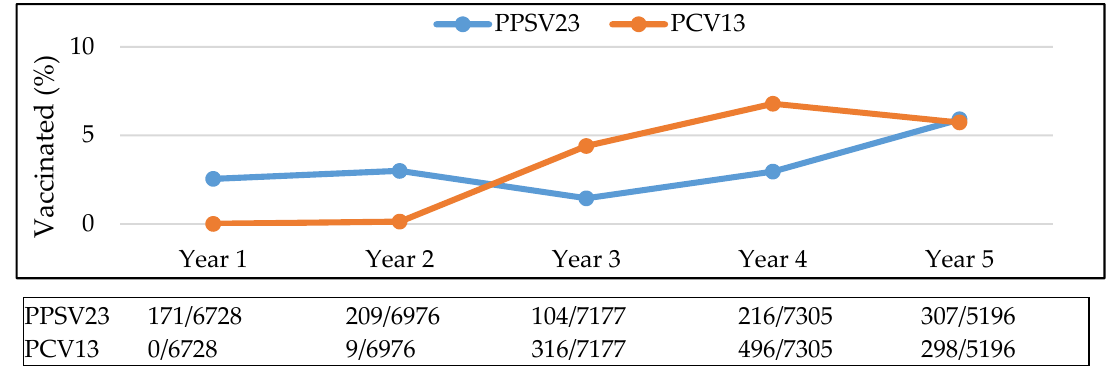
Figure 2. Yearly rate of vaccination. Abbreviations used: PPSV23: pneumococcal polysaccharide vaccine; PCV13: pneumococcal conjugate vaccine.